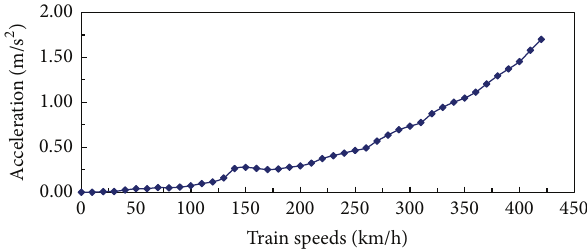
Figure 30: Maximum vertical acceleration of bridge girder mid- point under various train